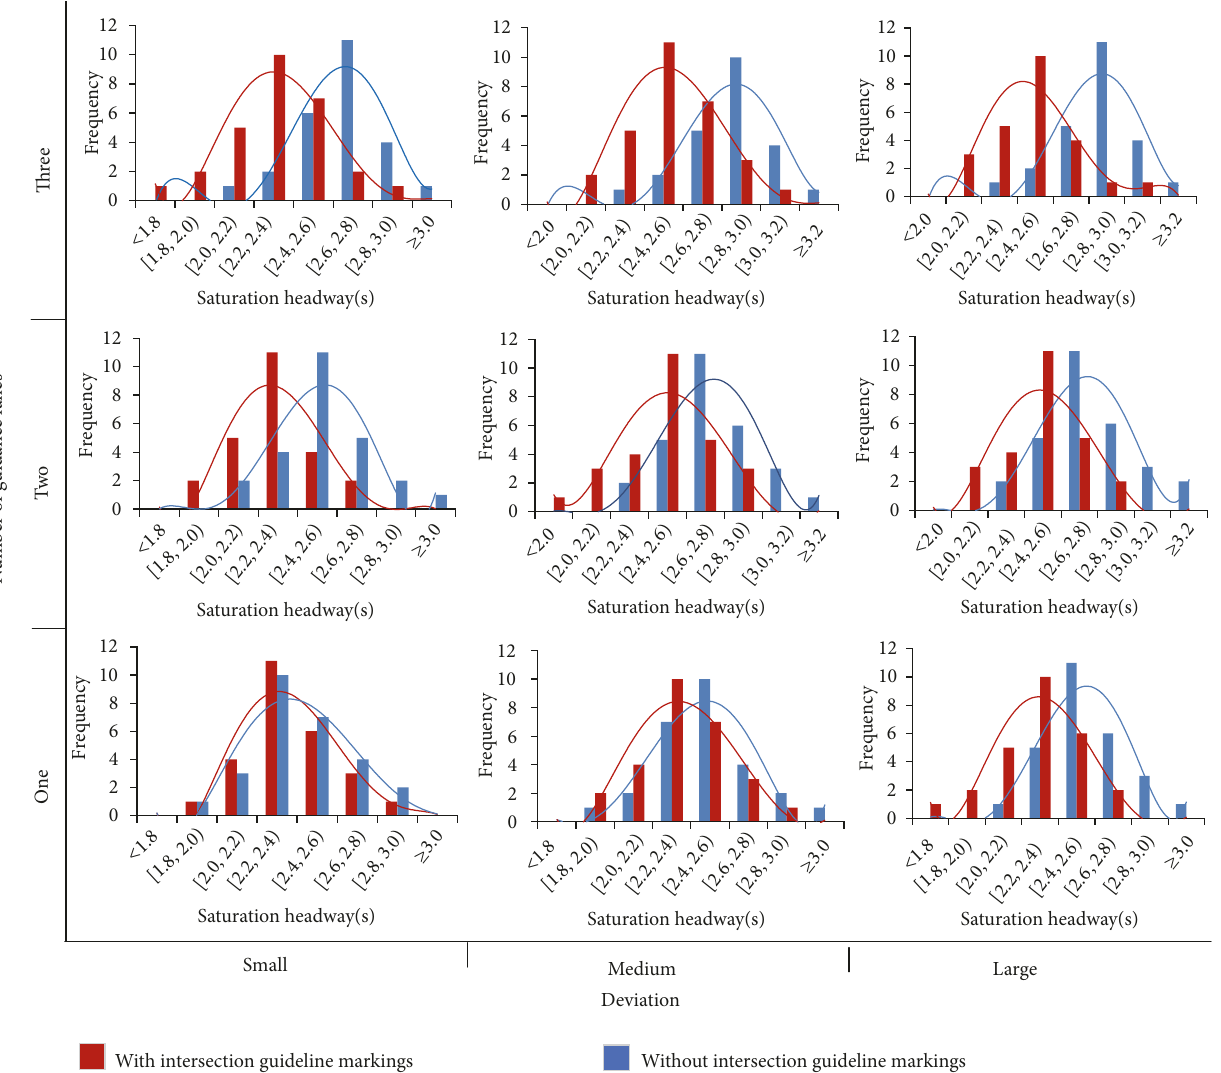
Figure 5: Comparison of through movement headways with and without guideline markings.